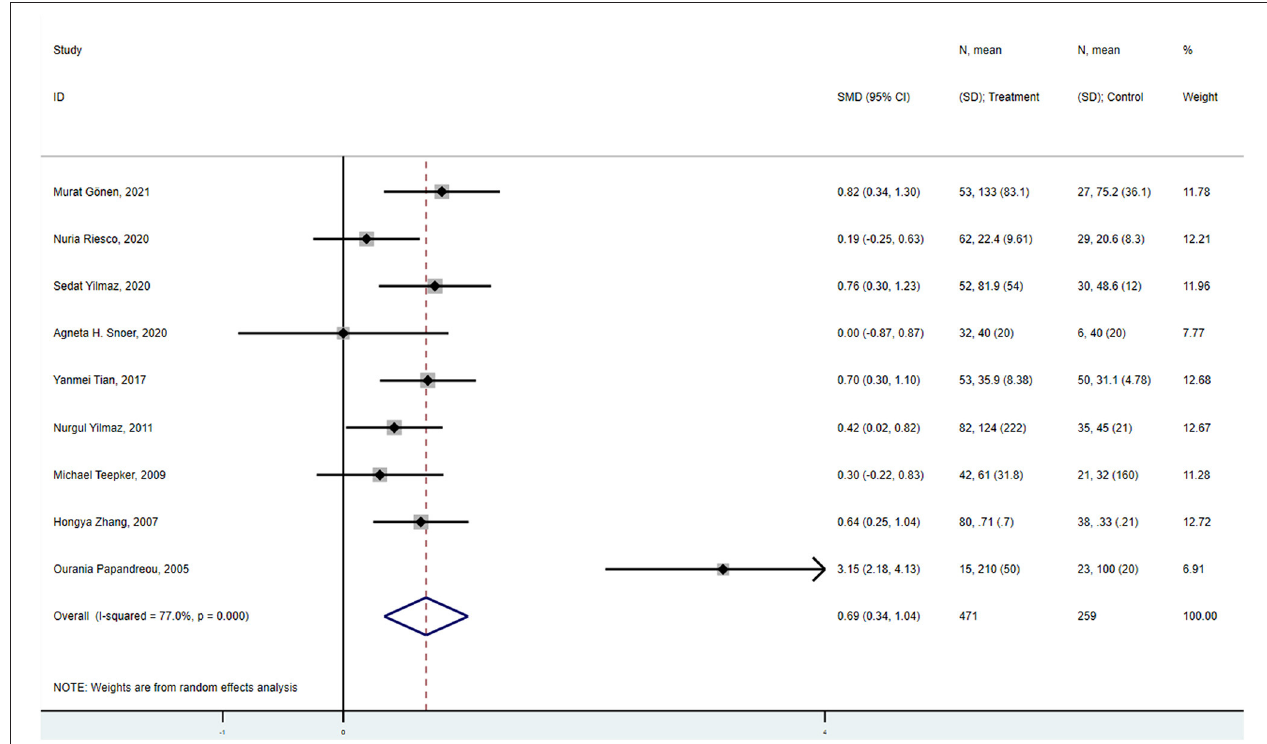
FIGURE 2 | Forest plot for the association between S100B levels and overall migraine. SMD, standardized mean difference; CI, confidence